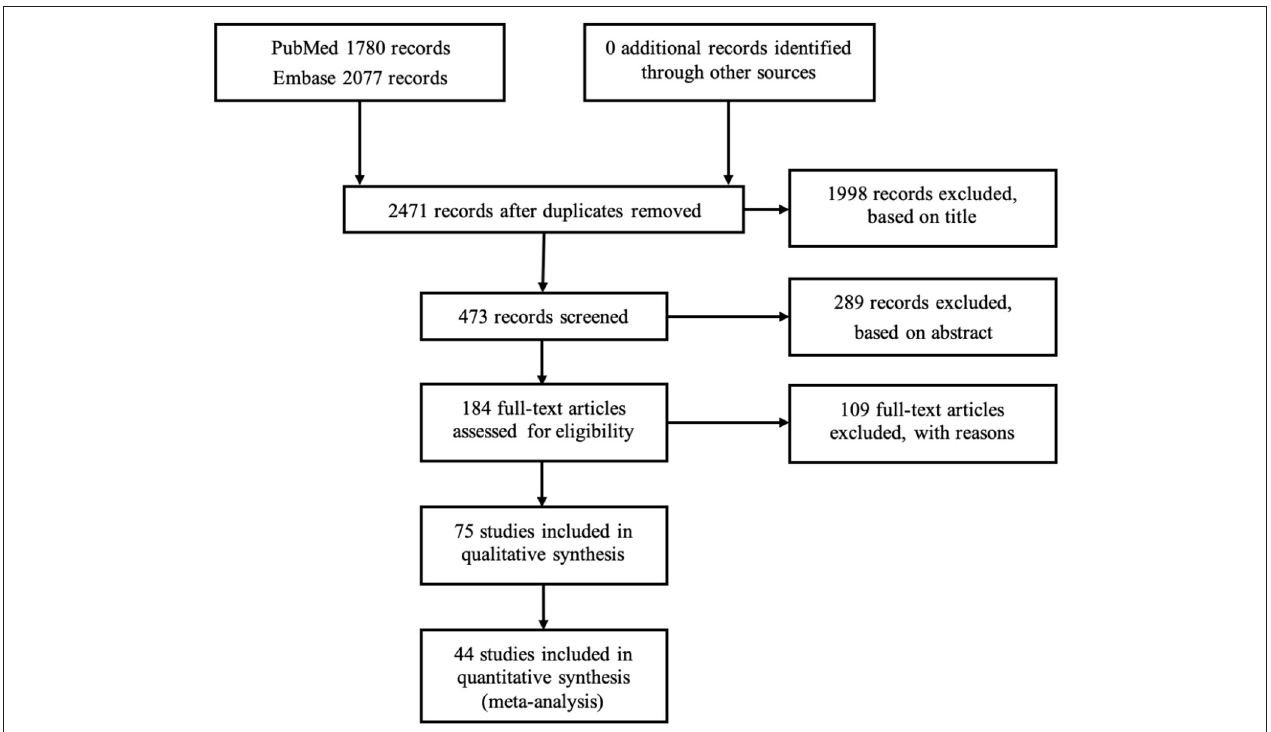
FIGURE 1 | Flow diagram of the study selection